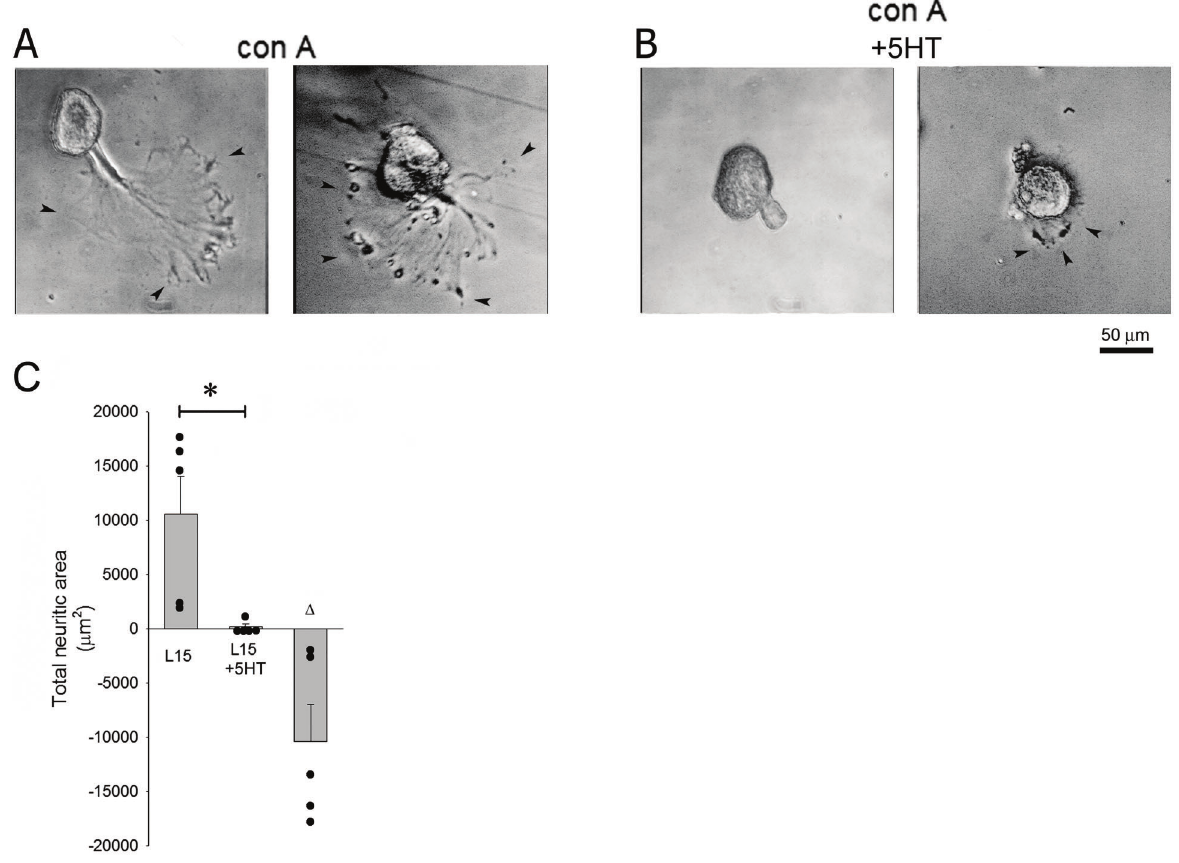
Figure 3. Effect of serotonin (5-HT) on growth of Retzius neurons cultured on the lectin concanavaline-A (Con-A). A , Retzius neurons cultured with the lectin Con-A yield neurites in the shape of extensive fan-like lamellipodia. The arrowheads show the edges of these structures. B , The presence of serotonin in the medium decreased the lamellipodia ’ s extension, and some neurons only yielded short and thin neurites. C , The total growth area decreased by 98%. D denotes the average difference ( ‘ with 5HT ’ minus ‘ without 5HT ’ ) for each pair of neurons from the same experiment. Data are reported as means ± SE. The asterisk denotes 95% statistical signi fi cance with the unpaired t